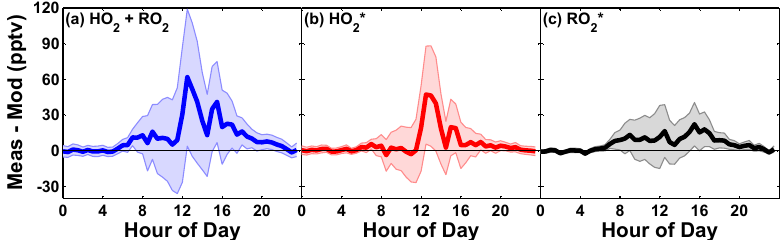
Fig. 5. Difference between observed and modeled peroxy radical mixing ratios: (a) total peroxy radicals, (b) HO ∗ are taken from the base simulation. Shaded areas represent the combined uncertainty from observed and modeled mixing ratios.